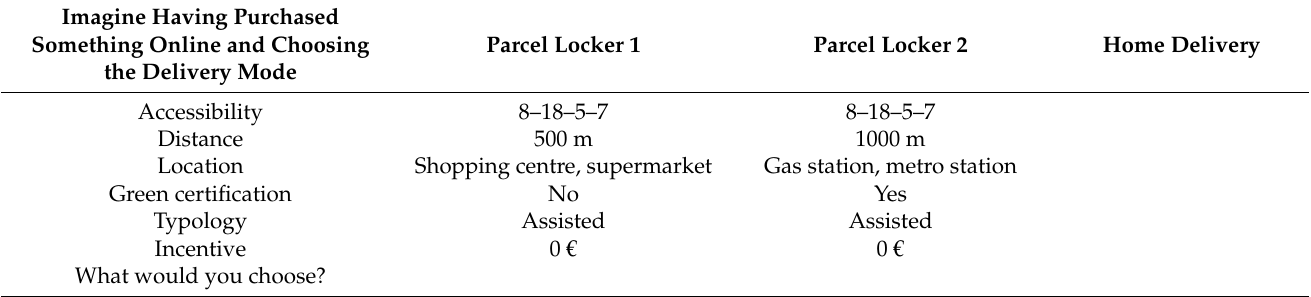
Table 1. Example of a choice task (Source: own